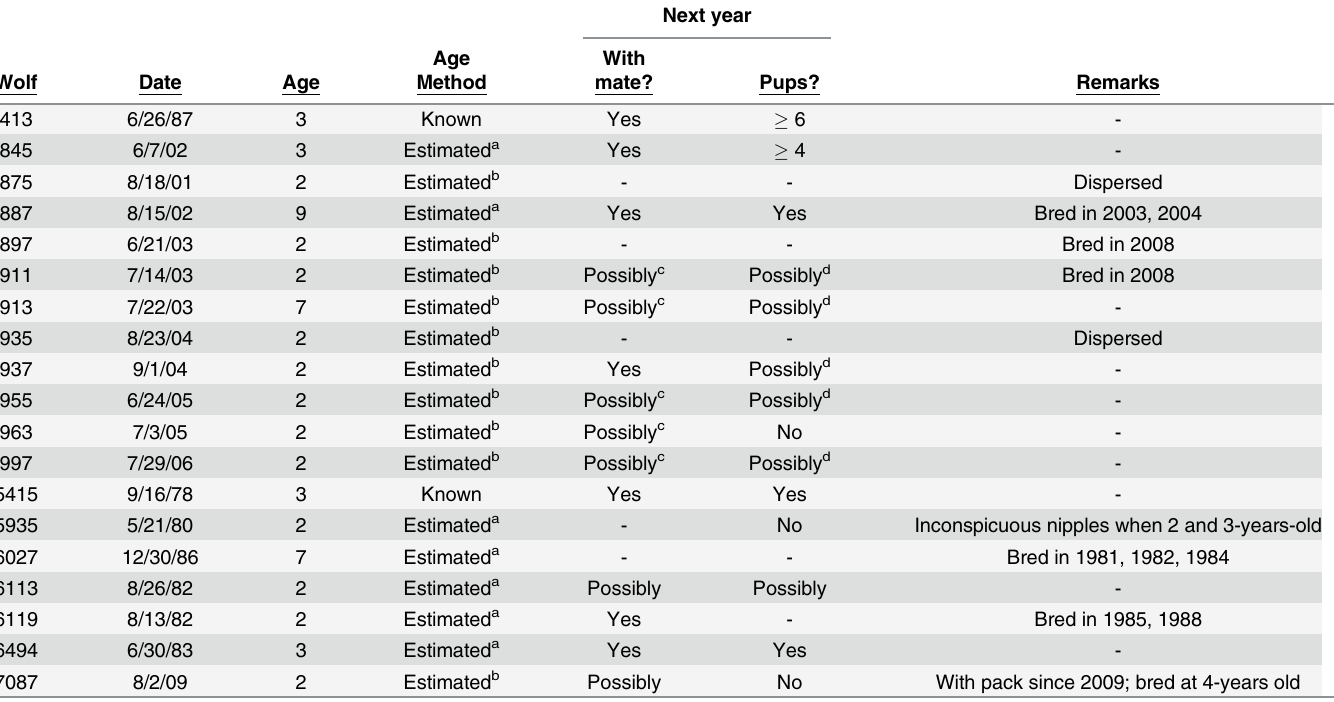
Table 4. Details about breeding status of female wolves (cid:1) 2-years old in the Superior National Forest that did not breed in their year of capture and for which past or future reproductive information is available. No additional information was available for 17 more wolves that did not breed in their year of capture.